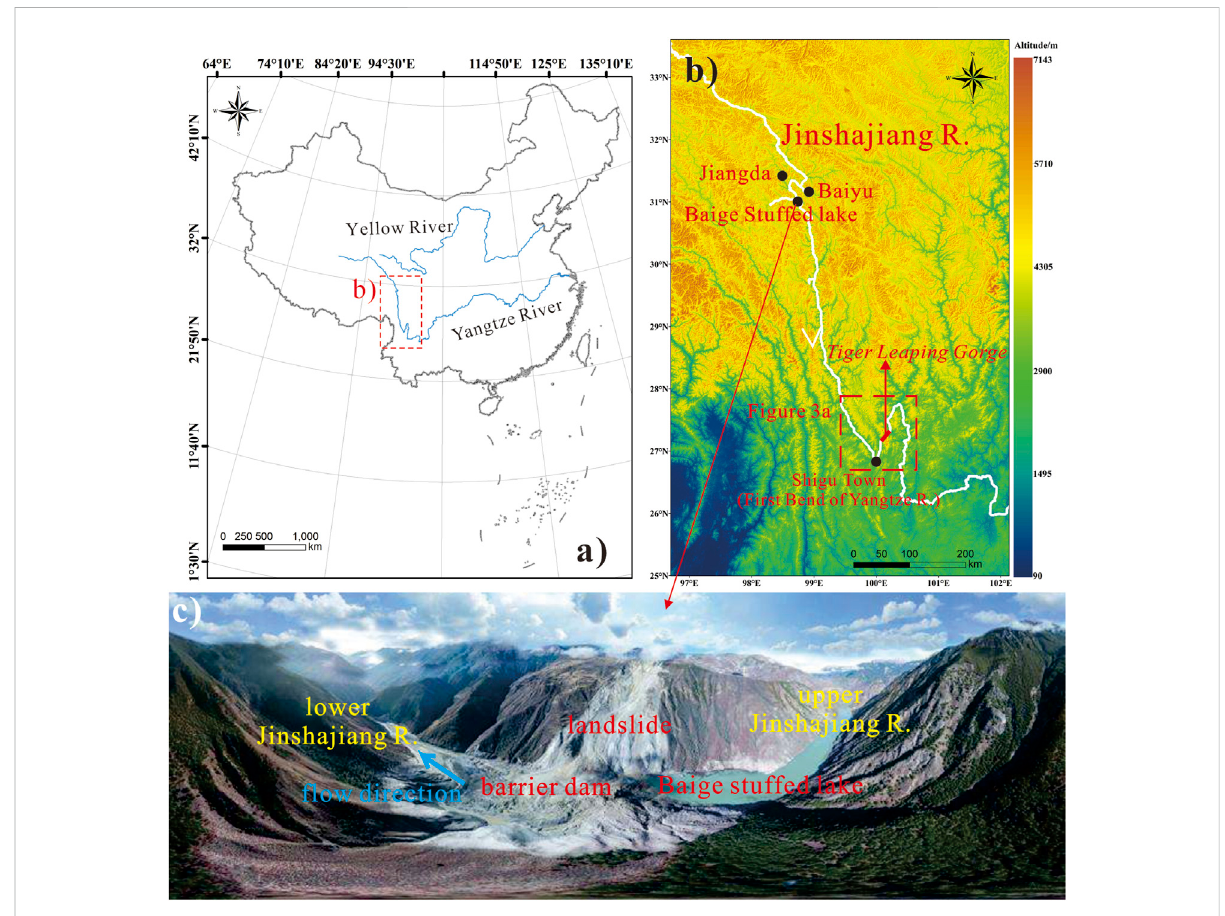
FIGURE 1 (A,B) Maps showing the location of the Jinsha River and the studied area. (C) Photograph of the Baige landslide dam (98 ° 42 ′ 17.98 ″ E and 31 ° 4 ′ 56.41 ″ N). Note that the picture was taken approximately 23 h after the landslide occurred, at 16:00 h on 5 November